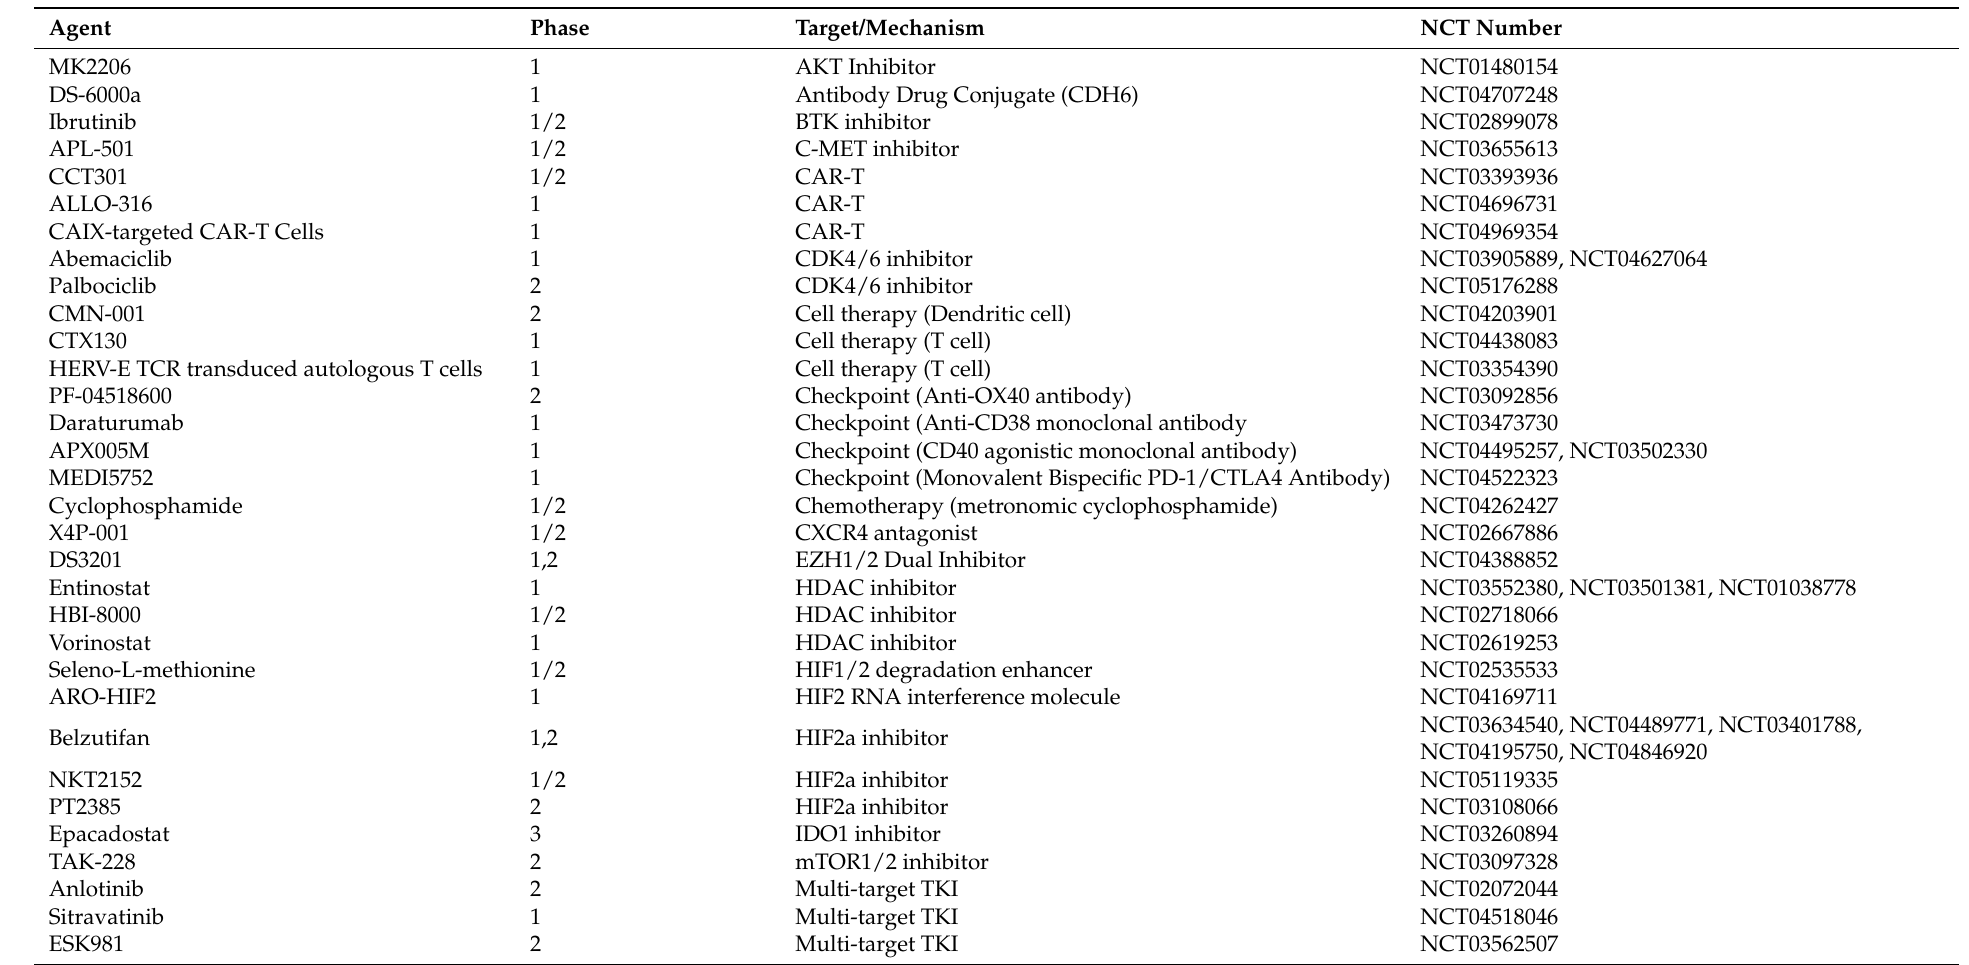
Table 4. Summary of selected potential candidates for novel treatment of advanced